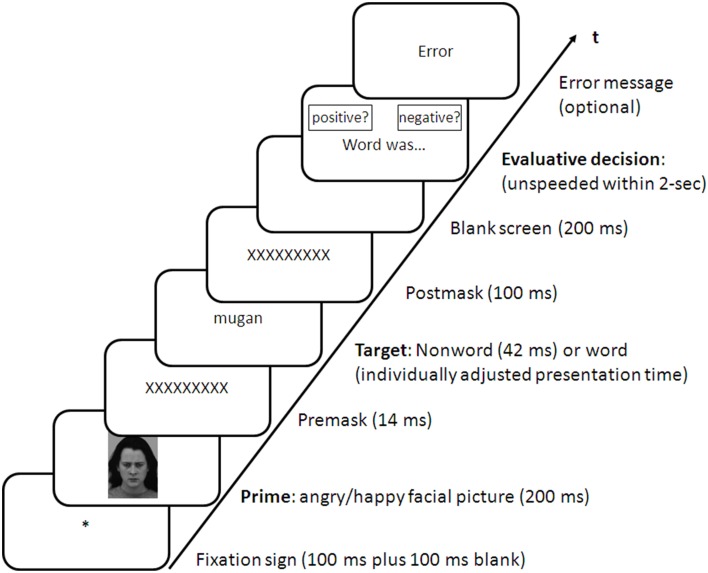
Sequence of events in an experimental trial in the word-identification conditions. Evaluative decisions were entered with left and right mouse button presses. The meaning of a key press was indexed by the respective location of response labels on left and right positions at the computer screen. In the fixed word-identification condition, the location of the response labels (i.e., the response mapping) was constant. In the variable word-identification condition, the location of the response labels varied unpredictably from trial to trial (see text for further explanation).